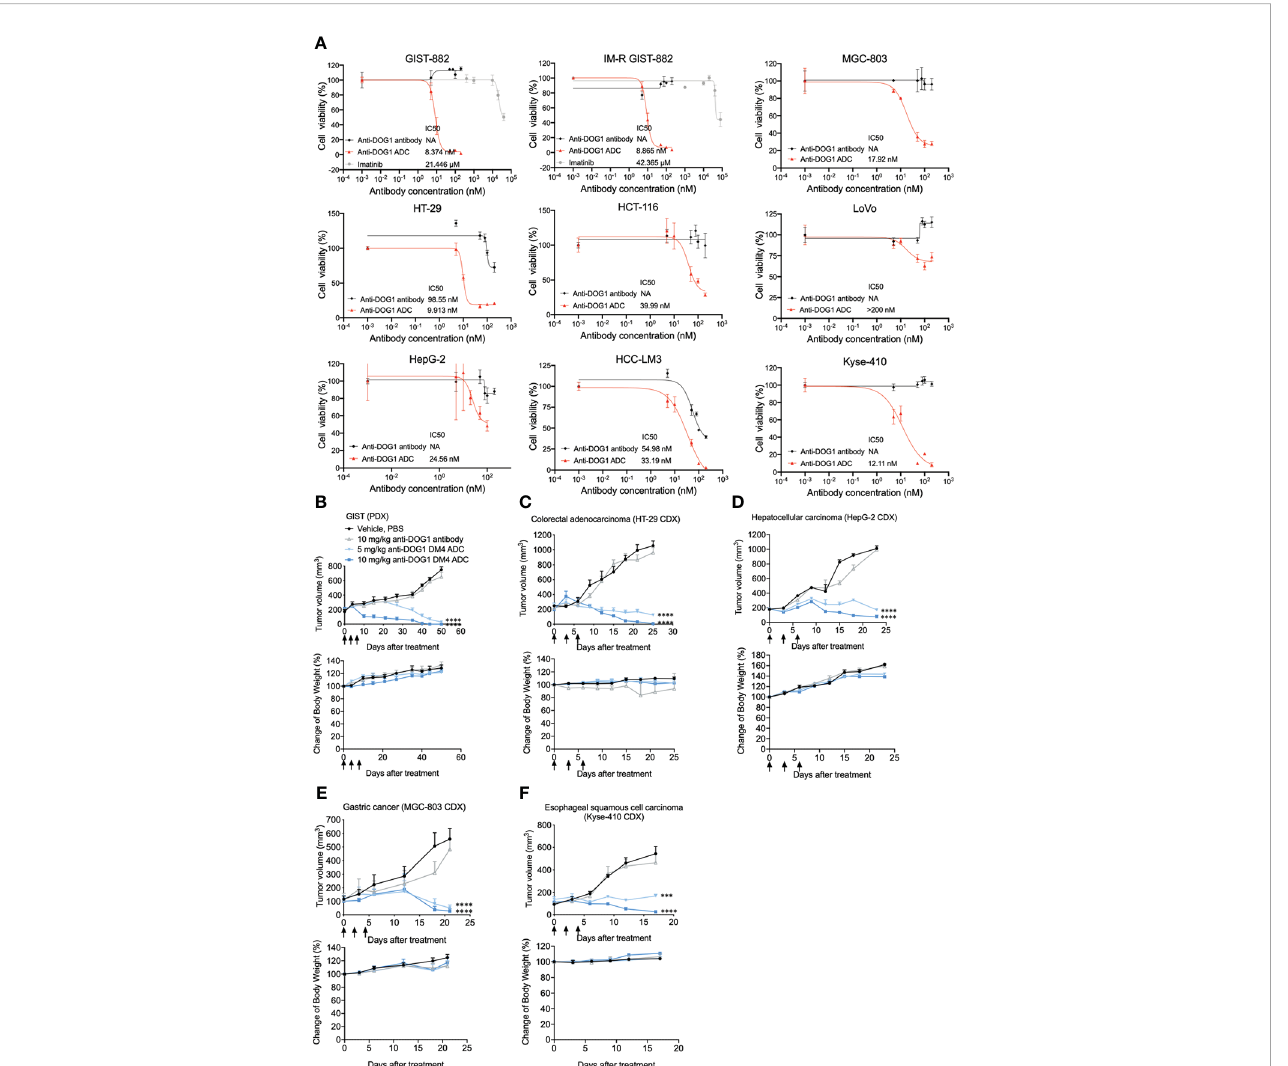
FIGURE 5 Anti-DOG1 ADCs showed potent in vitro and in vivo anti-tumor ef fi cacy in multiple types of gastrointestinal tumor. (A) GIST882 and IM-resistant GIST882 cell lines were incubated with increasing concentrations of IM, unconjugated anti-DOG1 antibodies and anti-DOG1ADCs for 72 h. HT-29, HCT-116, LoVo, HepG2, HCC-LM3, MGC-803, and Kyse-410 cell lines were incubated with increasing concentrations of unconjugated anti-DOG1 antibodies and anti-DOG1 ADCs for 72 h. The cytotoxicity was calculated by IC 50 . NA: not active; (B) GIST PDX model (n=5); (C) HT-29 CDX model (n=5); (D) HepG2 CDX model (n=7); (E) MGC-803 CDX model (n=5); (F) Kyse-410 CDX model (n=5) were i.v. dosed Q3Dx3 as indicated (arrow) with vehicle, unconjugated anti-DOG1 antibodies at 10 mg/kg and anti-DOG1 ADCs at 5 or 10 mg/kg. Data from the tumor growth studies are depicted as the mean ± SEM. Compared with the control group by one-way ANOVA. ***P <0.001; ****P <0.0001. The body weight data are depicted as the mean ±